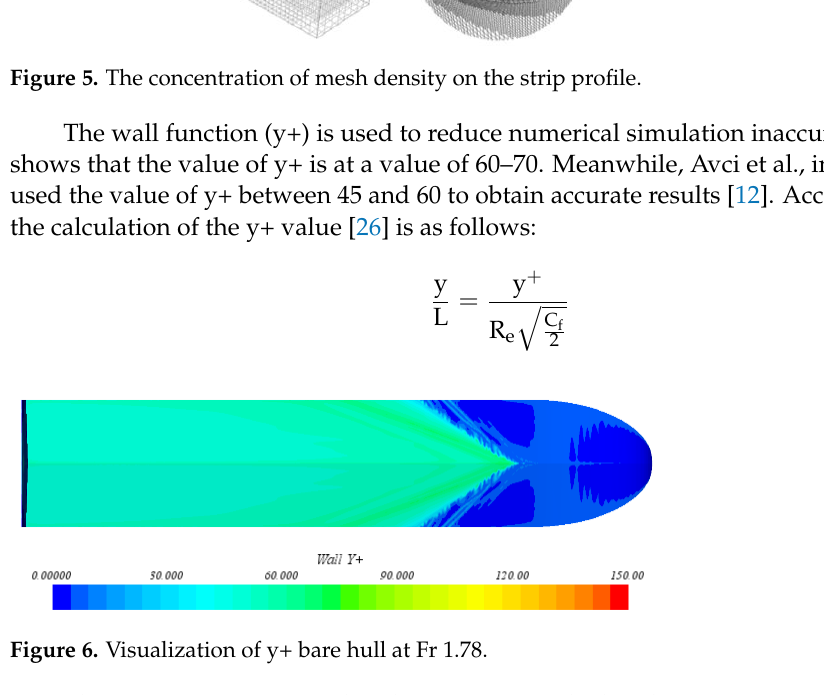
Figure 5. The concentration of mesh density on the strip profile.